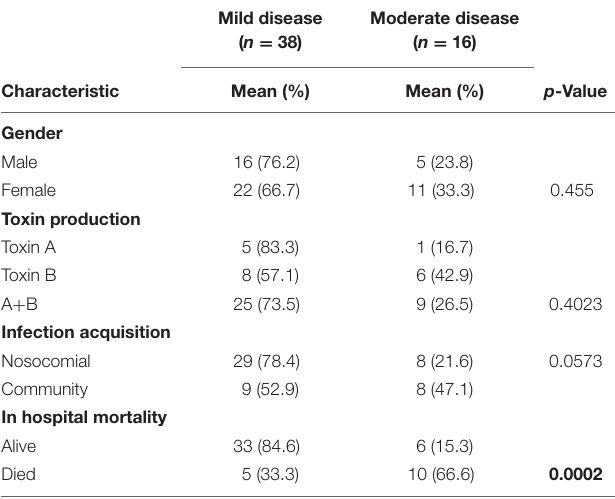
TABLE 1 | Summary of the demographic characteristics of CDI patients, divided to mild and moderate severity disease